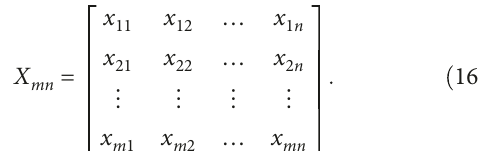
Table 2: The values of